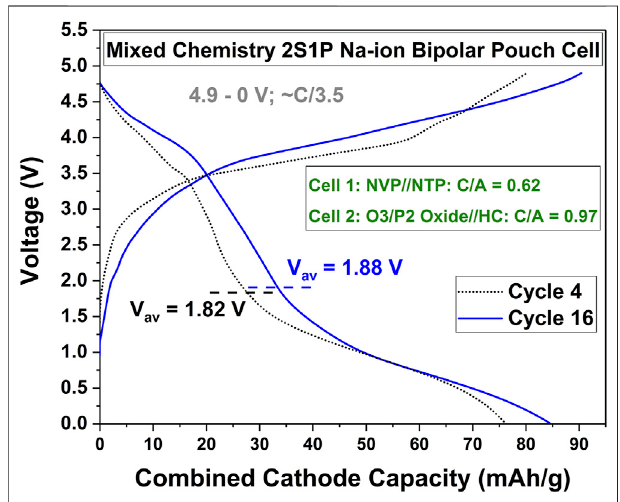
FIGURE 4 | Concept of Mixed Chemistry Bipolar n S m P Cells. Cycling curves of an NVP//NTP and O3/P2 Oxide//HC mixed-chemistry 2S1P bipolar Na-ion cell demonstrating a completely unique cycling pro fi le not possible from a single cathode//anode chemistry within a sealed